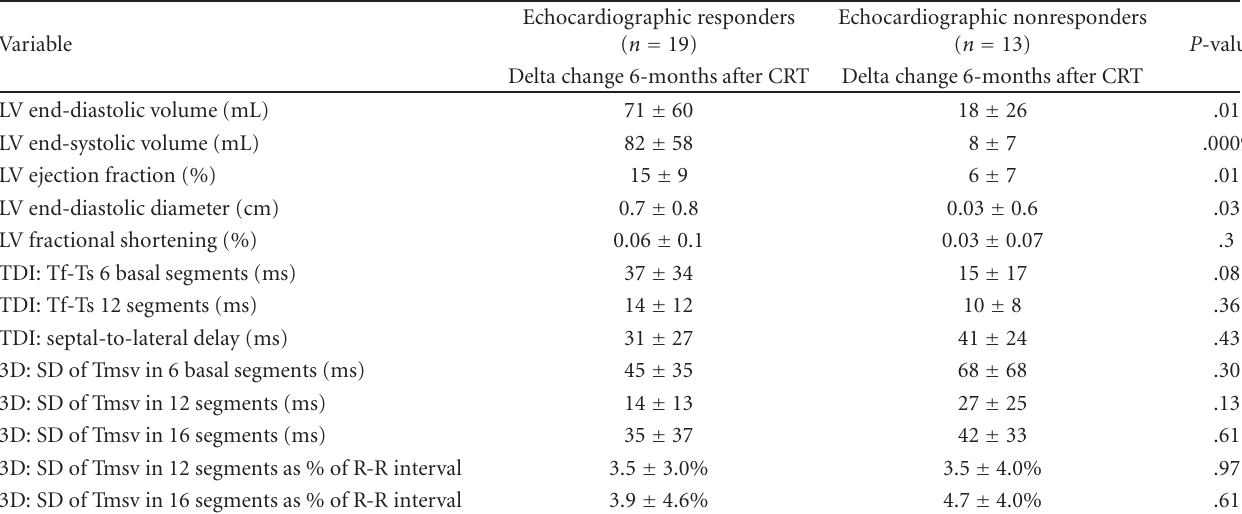
Table 3: Di ff erence in left ventricular function and dyssynchrony parameters in echocardiographic responders versus nonresponders after long-term CRT.